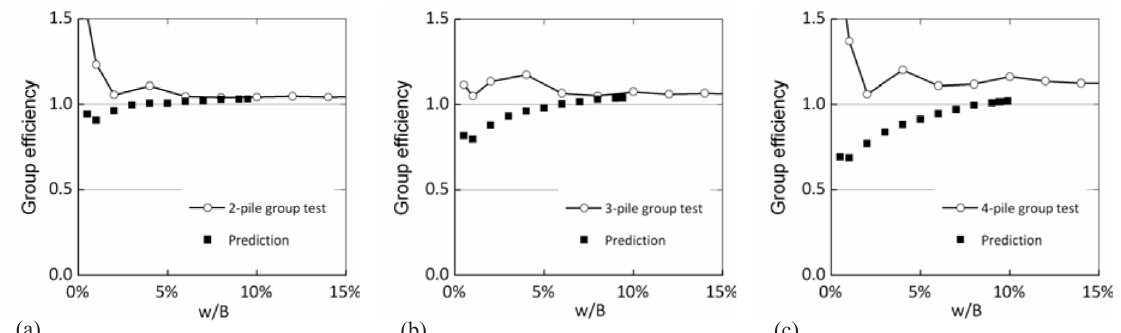
Fig. 17. Comparison of group efficiency calculated for measured and predicted pile group response in medium dense sand ( S/B = 3): (a) 2-pile group; (b) 3-pile group; (c) 4-pile group